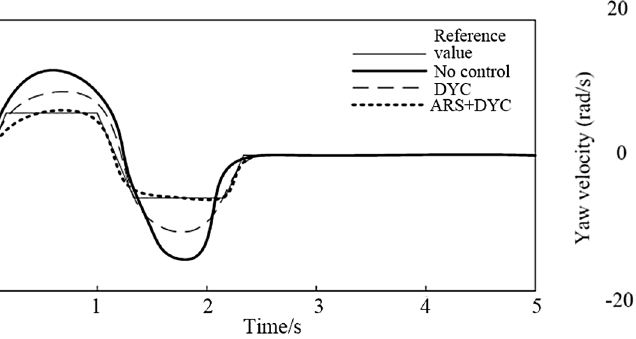
Fig. 2. Yaw velocity response.